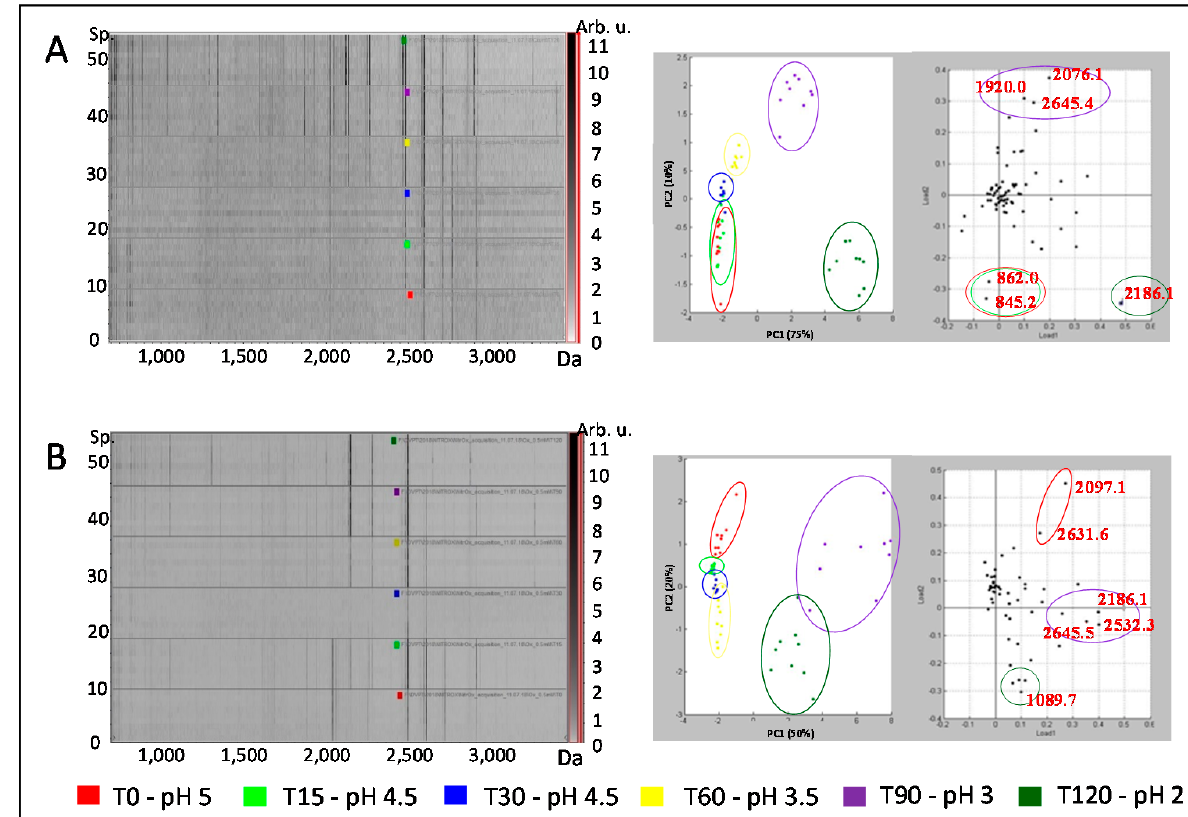
Figure 2. MALDI-TOF spectra of creatine kinase digestate by pepsin ( A ) and oxidized pepsin at 3 mM FeSO 4 /DETAPAC/H 2 O 2 ( B ) monitored through the kinetic of gastric acidification, from 0 (in red) to 120 min (in dark green), to pH 5 to pH 2, respectively. MALDI-TOF individual spectra ( n = 9 per each condition) are represented as a gel-view in the upper part. Principal component analysis of peptide spectra consists of the score plot on the upper part and the loading plot on the lower part. The peptides spectra resulting from the hydrolytic activity of pepsin on CK showed a progressive profile with the appearance of a lower molecular weight peak, below 2500 Da, all along the hydrolysis kinetic, from the bottom (at T0, in red) to the top (at T120,